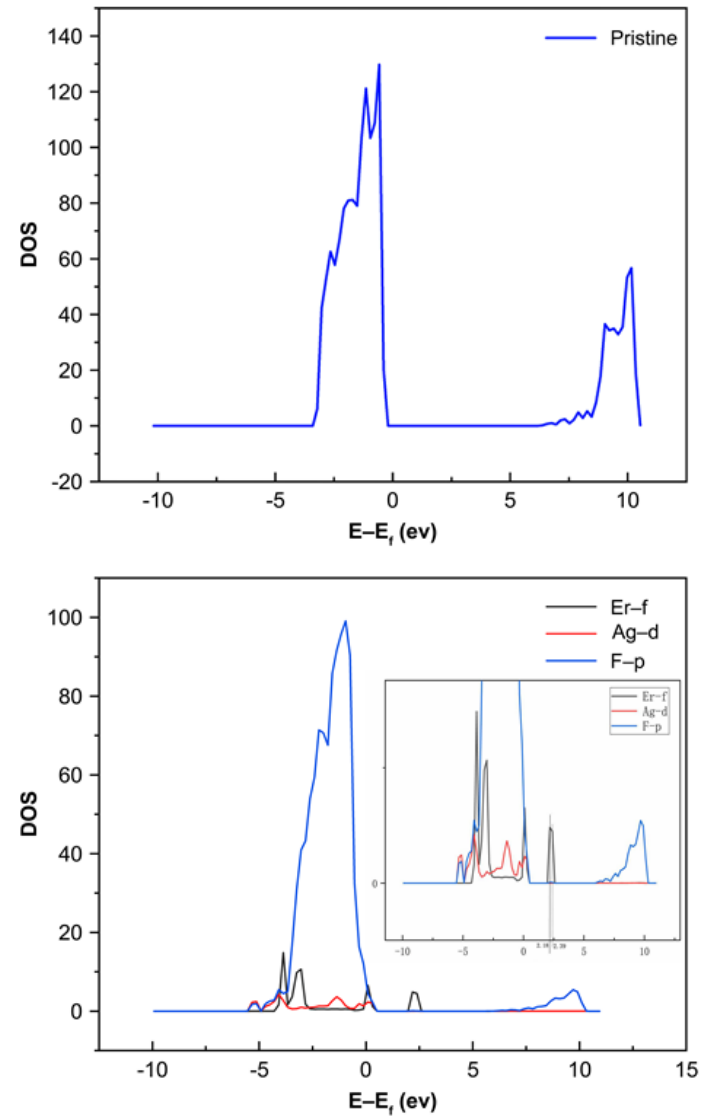
Figure 7. Computed DOS of the perfect NaYF 4 and Er-Ag-NaYF 4 doping structures and local enlarged image of Er-Ag-NaYF 4 doping structures.